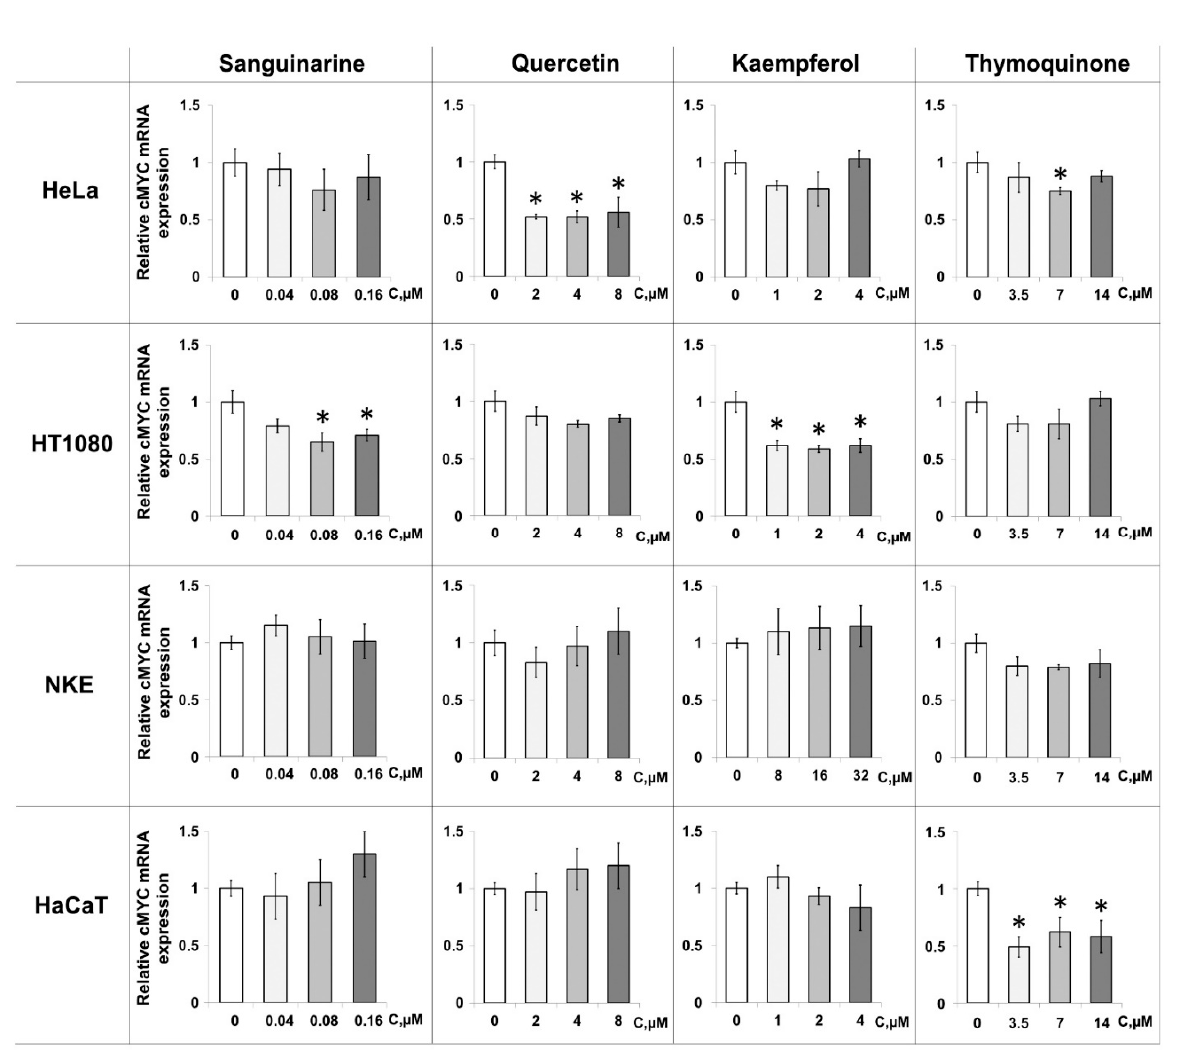
Figure 5. Effects of PSMs on c-MYC expression determined by RT-PCR in cancer (HeLa and HT1080) and immortalized (HaCaT and NKE) cell lines. All data are presented as M ± m. * Differences are statistically significant compared to control ( p < 0.05).